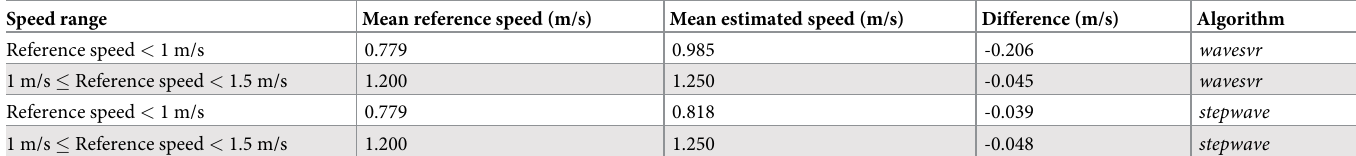
Table 3. Mean difference between reference speed and estimated, grouped by speed range. Both listed speed estimation algorithms utilize the stepwave step detection approach.